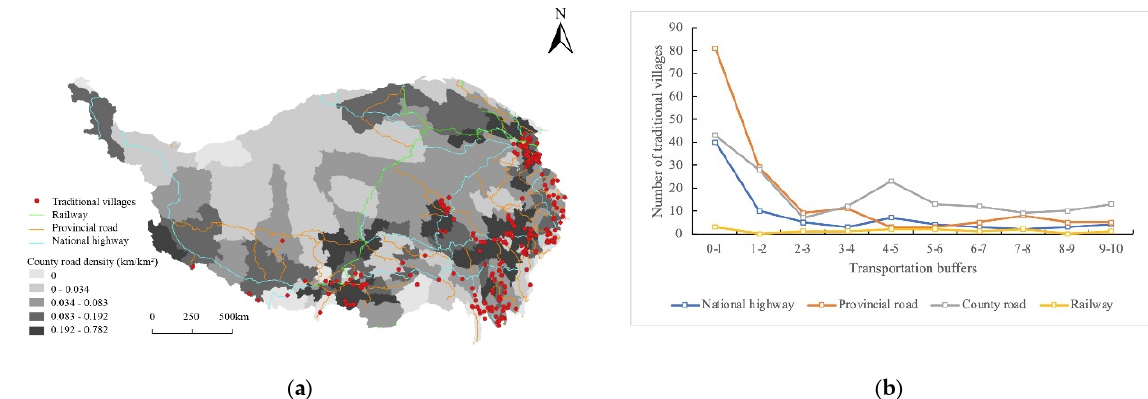
( b ) Figure 12. Distribution of traditional villages coupled with water systems on the Tibetan Plateau: ( a ) the spatial overlay analysis of village distribution and water systems; ( b ) statistics of traditional villages in different water buffers. 3.2.2. Socioeconomic Factors Transportation The locations of roads and railways are related to the distribution of traditional vil- lages. The road transportation system has the greatest influence on the distribution of tra- ditional villages, whereas the railway system has little effect. County roads have the great- est influence on the spatial distribution of traditional villages and play the role of “capil- laries” within the overall transportation system. The study applied Pearson’s correlation analysis to justify the association between the distribution of traditional villages and trans- portation. The result of the correlation coefficients between the number of traditional vil- lages and the density of railways ( − 0.048), county roads (0.104), provincial roads ( − 0.057),